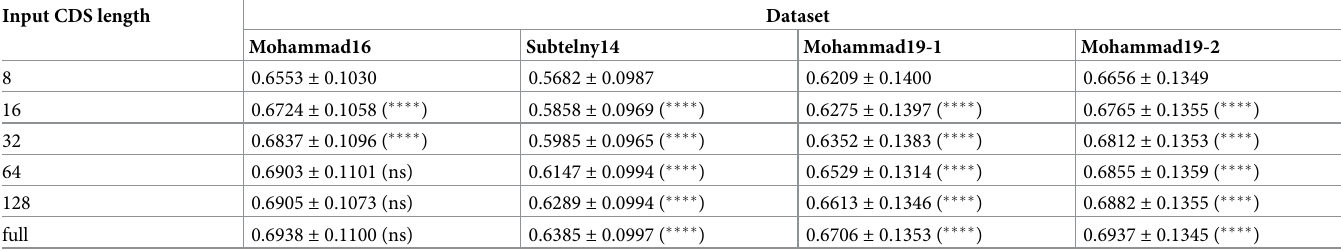
10-fold cross-validation through randomly splitting genes into training and test sets was performed on the four datasets to assess the performance of the model with each input CDS length. The gene-wise correlations were computed by comparing the predicted and measured ribosome densities for individual genes in the test set at each 10-fold cross-validation. The mean ± SD of the gene-wise Pearson’s correlation coefficients across the whole dataset are shown. Significant levels from Friedman tests with Dunn’s multiple comparison correction are shown in the parentheses. The statistical tests were conducted by comparing each group (e.g., with input CDS length of 16) with the previous group (e.g., with input CDS length of 8).